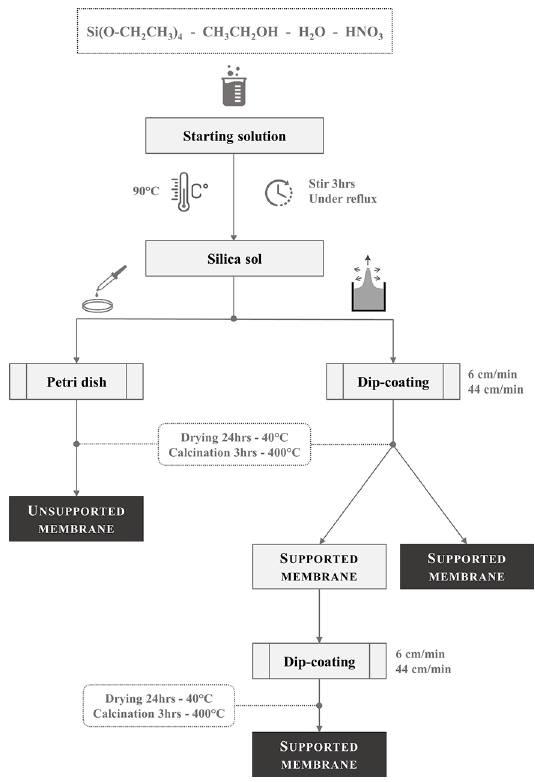
Figure 2. Schematic diagram of the silica membrane